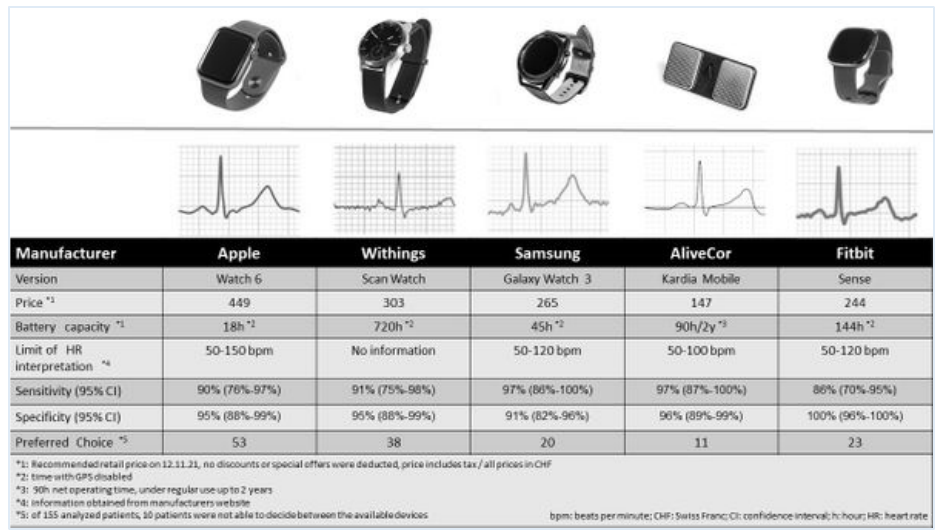
Figure 1: Comparison of analyzed devices with picture of used device and electrocardiogram as shown on saved PDF, produced by manufacturers